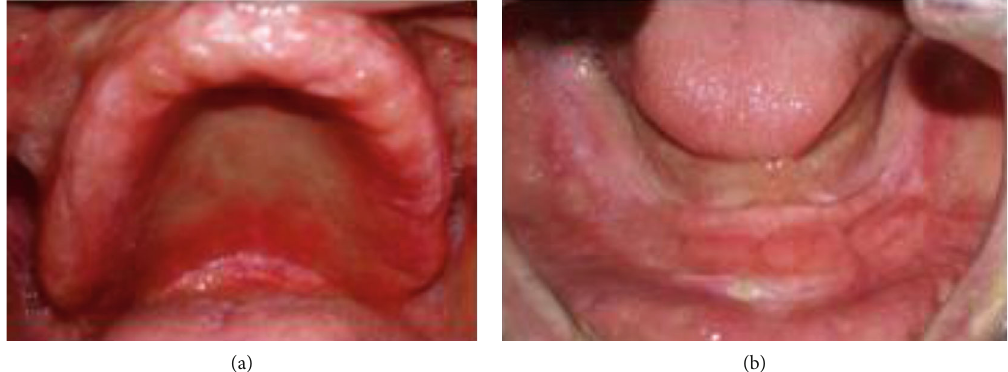
Figure 11: Intraoral examination: (a) fl abby tissue in the maxillary anterior region and (b) fi brous hyperplastic